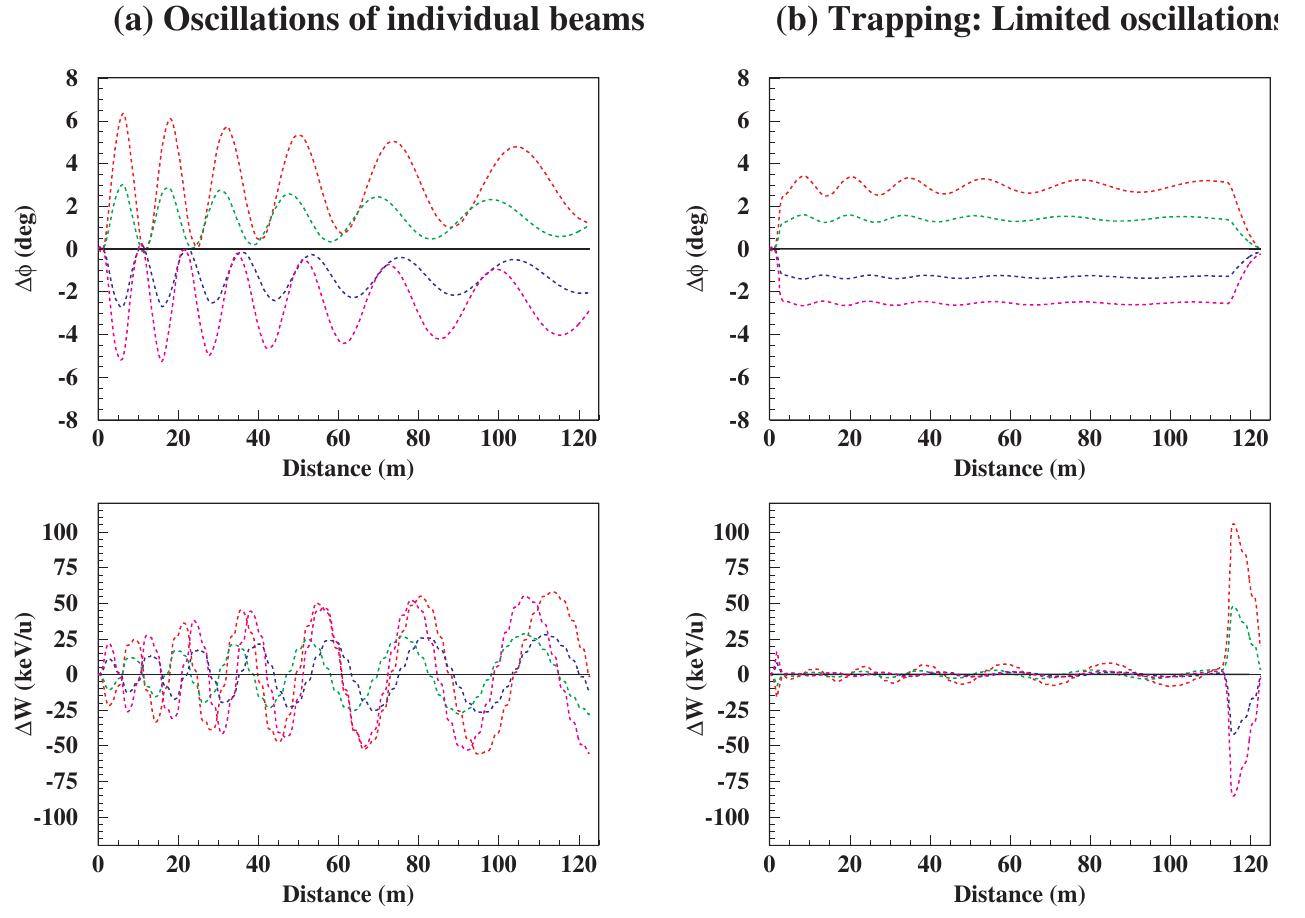
FIG. 4. (Color) Beam phase and energy centroid deviations for the different charge states (dashed curves) with respect to the reference charge state (solid line) plotted as function of distance along the single frequency option of the medium- (cid:1) section of the RIA driver linac. (a) Case where all cavity phases are set to (cid:1) 30 (cid:6) showing the oscillations of individual charge state beams. (b) Case where few cavities are used to bring the reference phases of individual charge state beams to their corresponding synchronous phases in order to limit beam oscillations and produce more stable beam